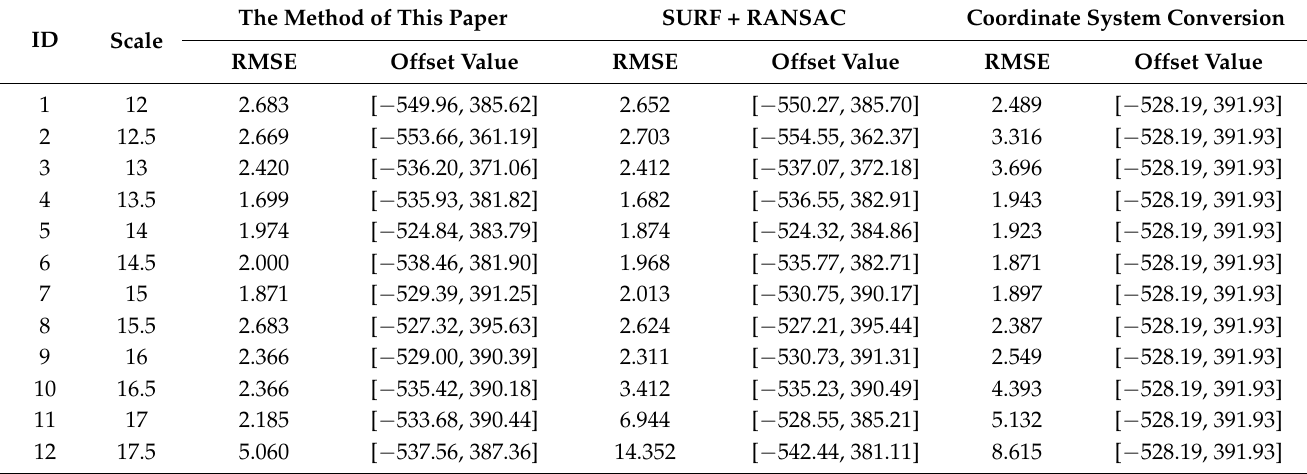
Table 2. Registration results of three methods in remote sensing maps of Ganzhou.